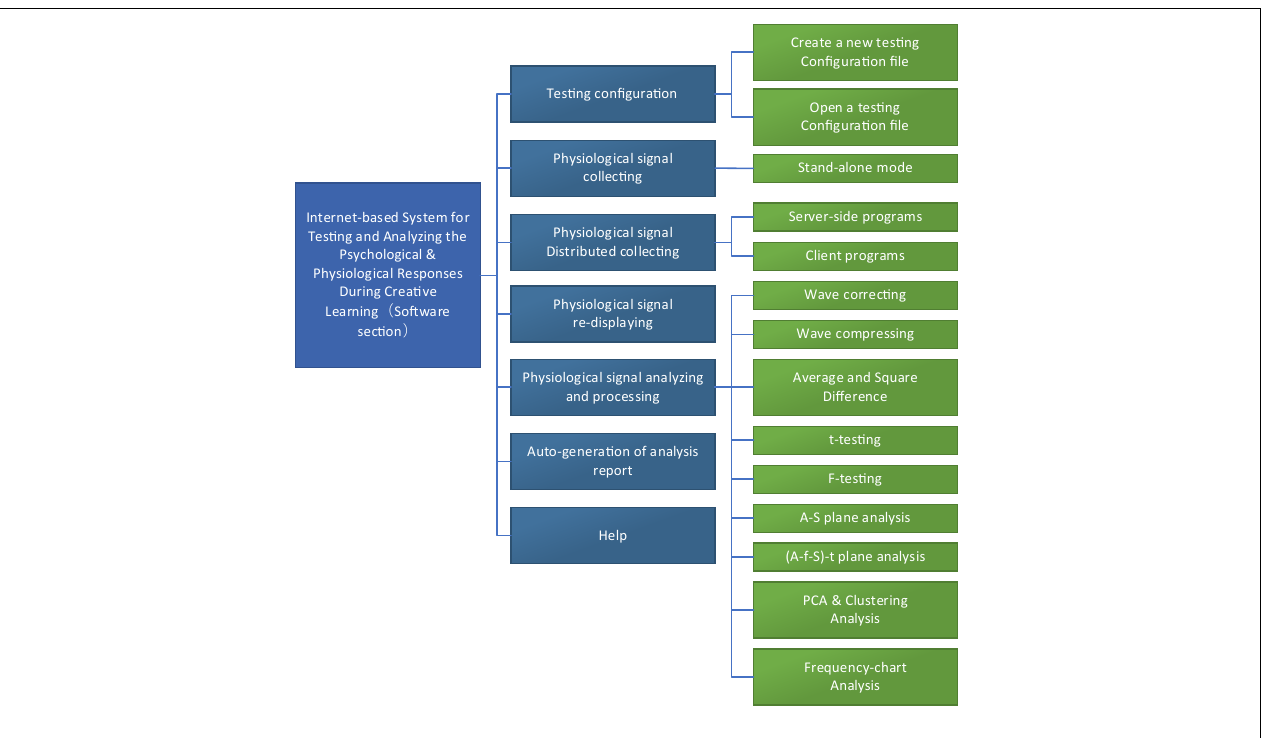
FIGURE 5 | Functional modules of the